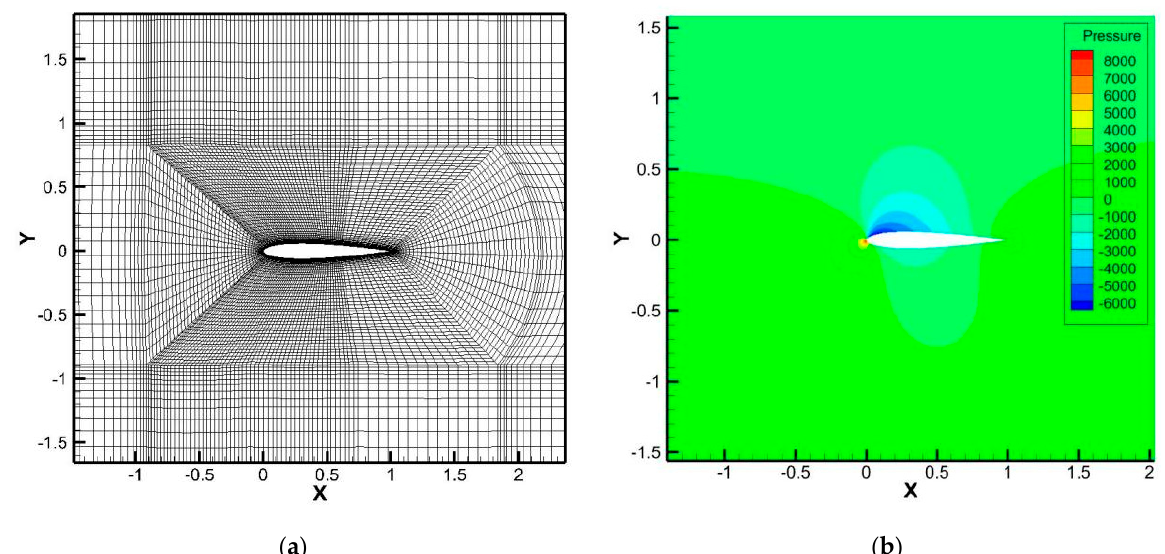
Figure 7. Flow fi eld calculation results: ( a ) grid of airfoil; ( b ) fl ow fi eld.